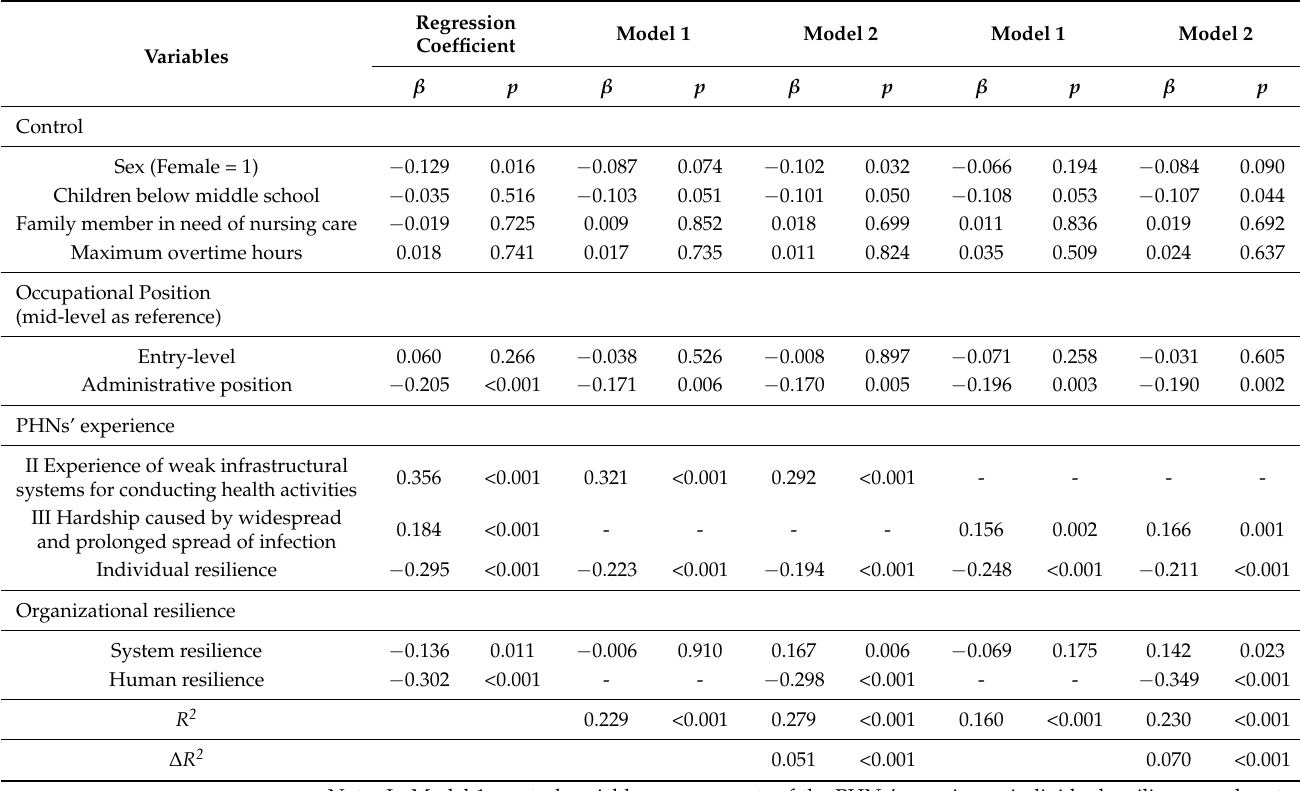
Table 7. Hierarchical multiple regression analysis with depersonalization as the dependent variable, and experience, individual resilience, and organizational resilience as the independent variables (N =